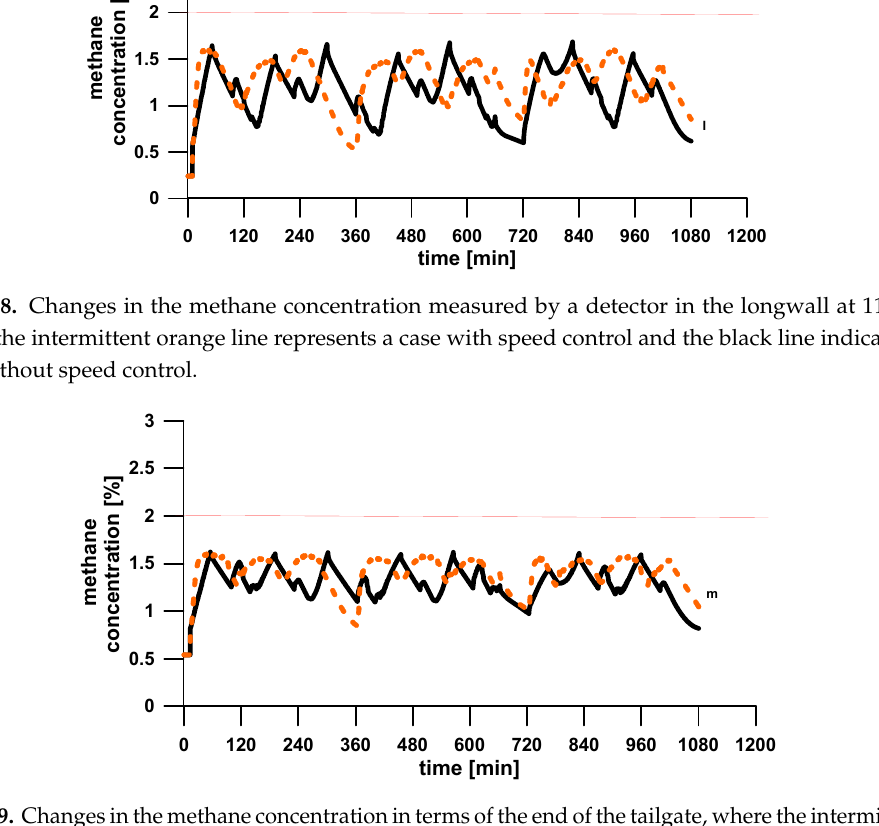
Figure 9. Changes in the methane concentration in terms of the end of the tailgate, where the intermittent orange line represents a case with speed control and the black line indicates a case without speed control.